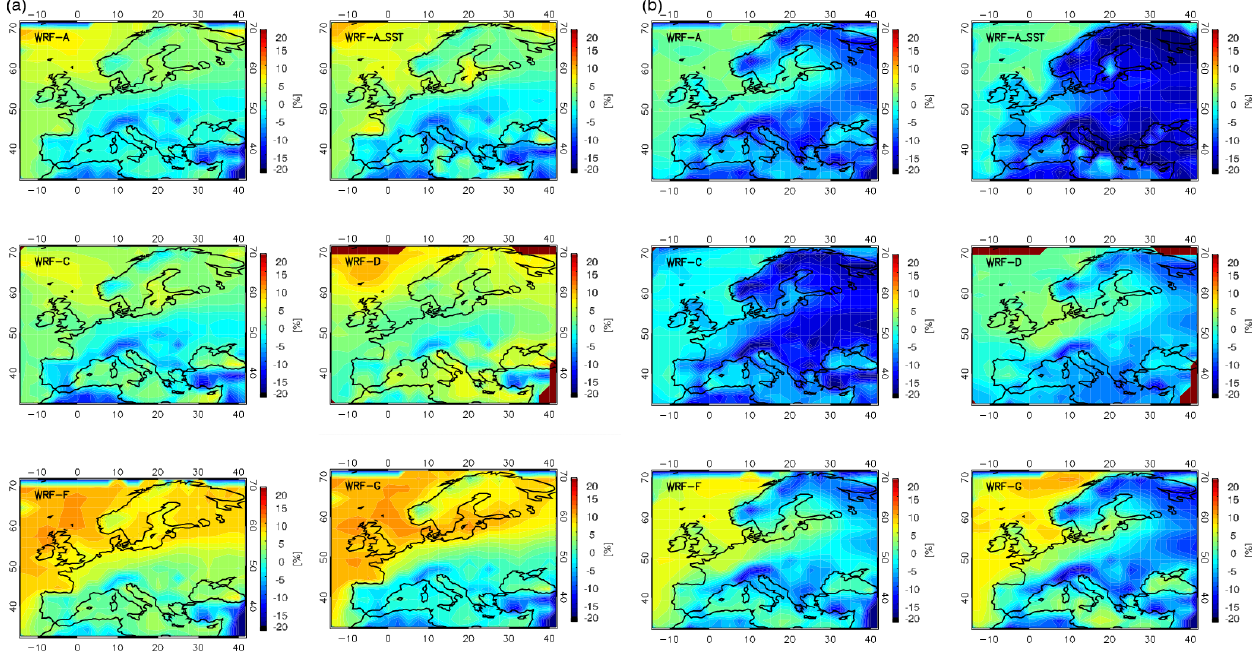
Figure 7. (a) Mean summer and (b) mean winter 1990–2008 downward surface longwave radiation bias